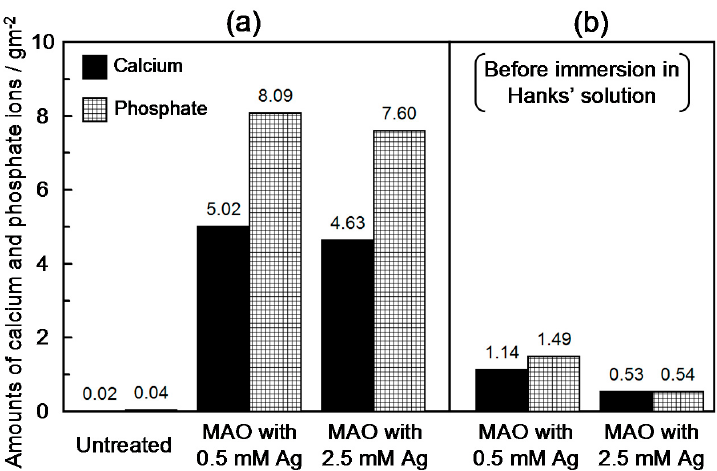
Figure 5. Amount of calcium and phosphate ions formed on TNTZ specimen surfaces in Hanks’ solution determined by ICP ‐ AES.